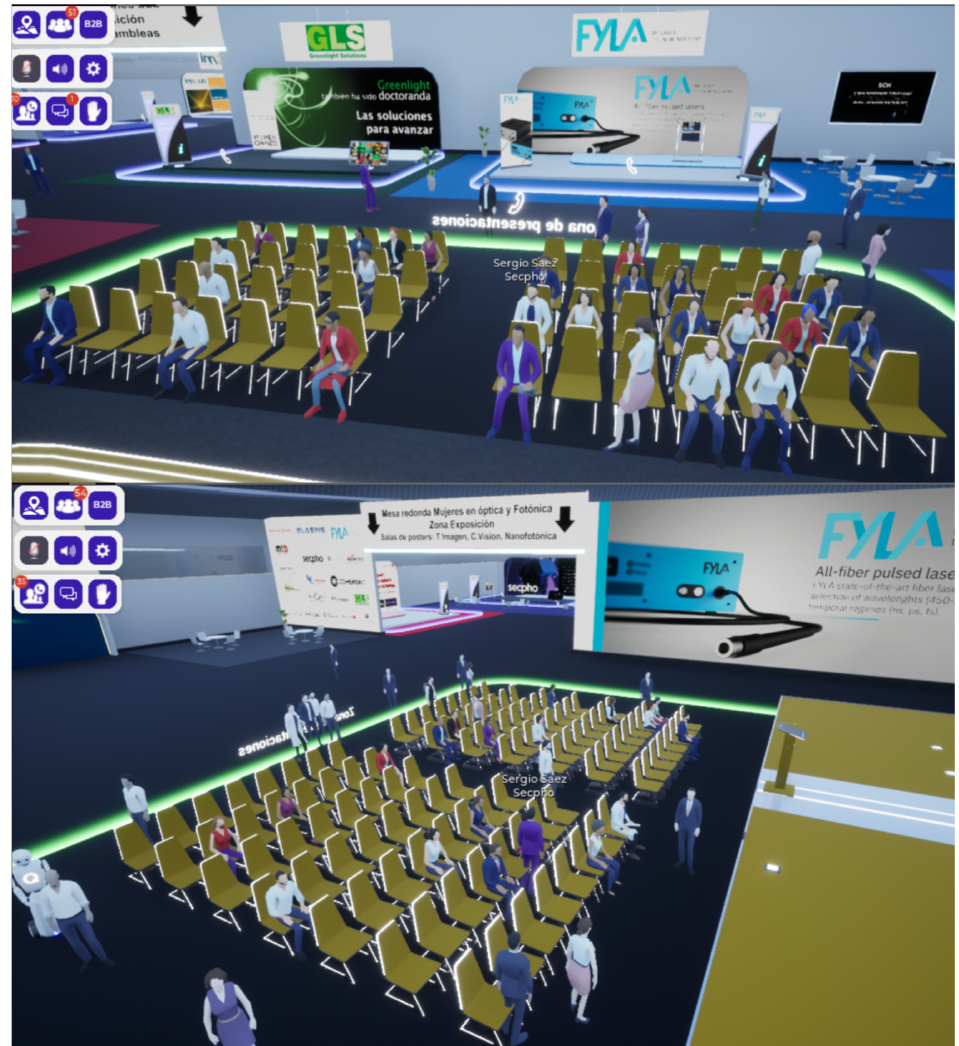
Figure 1. Snapshots of the Secpholand platform during RNO2021 showing the auditoriums. Some stands of the sponsors are visible behind the auditorium in the top